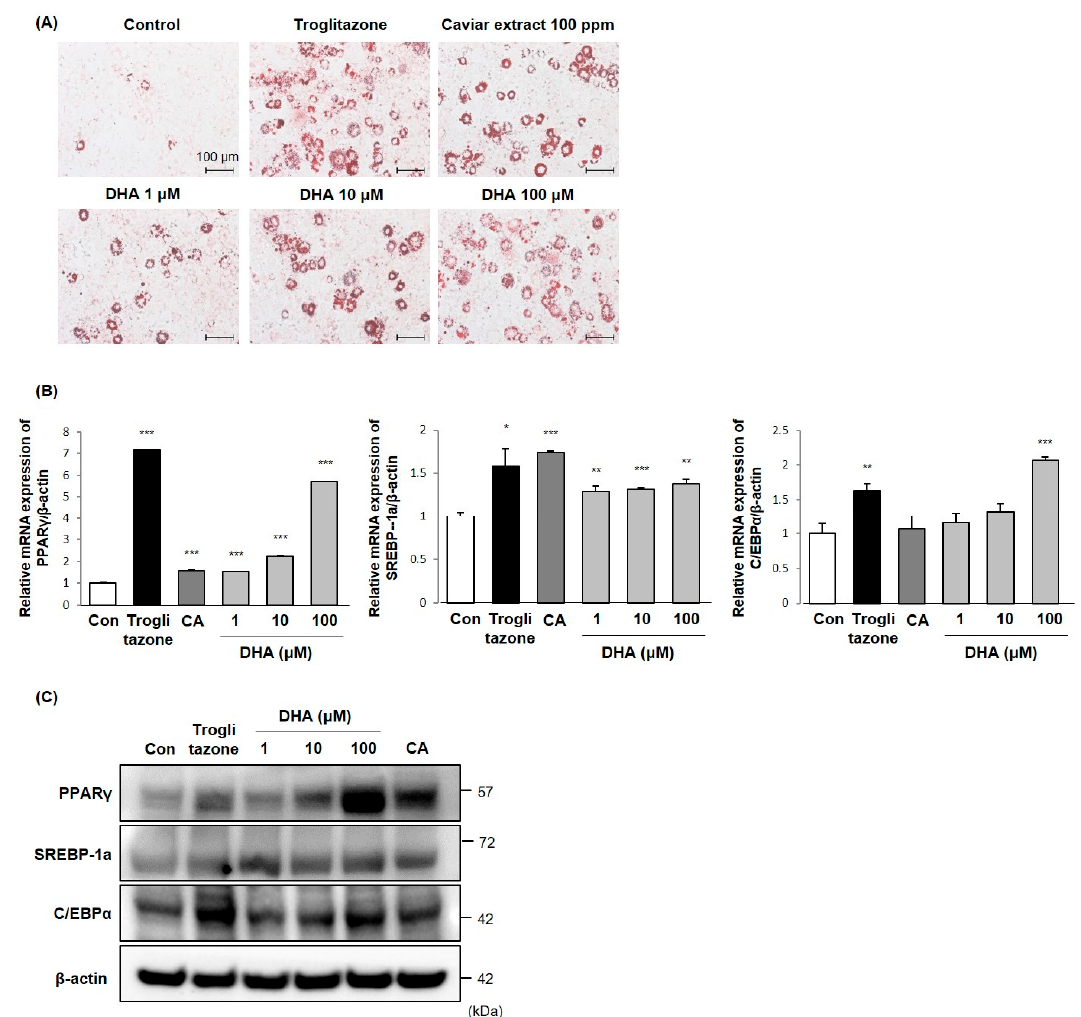
Figure 3. DHA increased adipocyte di ff erentiation. The 3T3-L1 cells were di ff erentiated with treatment of DHA, caviar extract, or troglitazone for 6 days. ( A ) Observation of morphology and Oil Red O staining of di ff erentiated 3T3-L1 cells were photographed using a light microscope (X200). Lipid droplets are stained red, and the data are representative of three independent experiments. PPAR γ , SREBP-1a, and C / EBP α ( B ) mRNA and ( C ) protein levels were measured by RT-qPCR and immunoblotting. The means ± SEs are the average of three independent experiments. * p < 0.05, ** p < 0.01, and *** p < 0.001 indicate a significant di ff erence from the control.